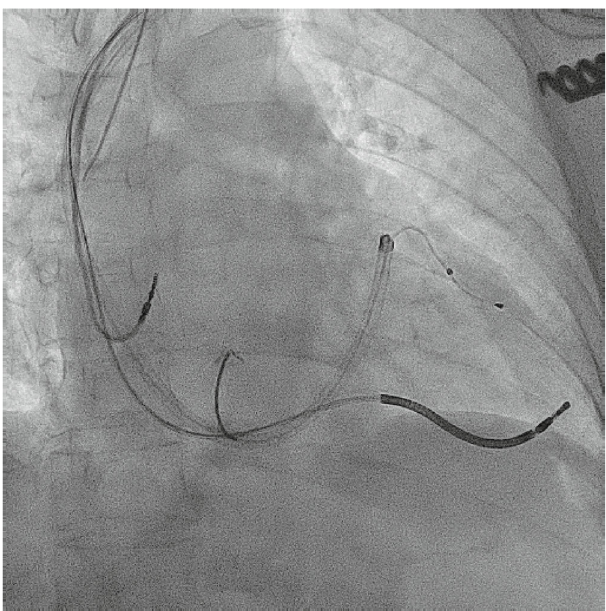
Figure 1: Shock and pace/sense leads in the branches of the coronary